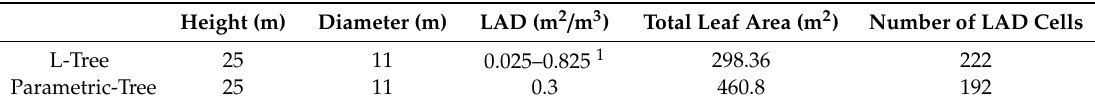
Figure 4. L-Tree with leaf area density (LAD) ranging from 0.025 to 0.825 m 2 /m 3 ( a ); Parametric-Tree with homogenous LAD of 0.3 ( b ). Table 1. Parameters of Parametric-Tree and L-Tree.